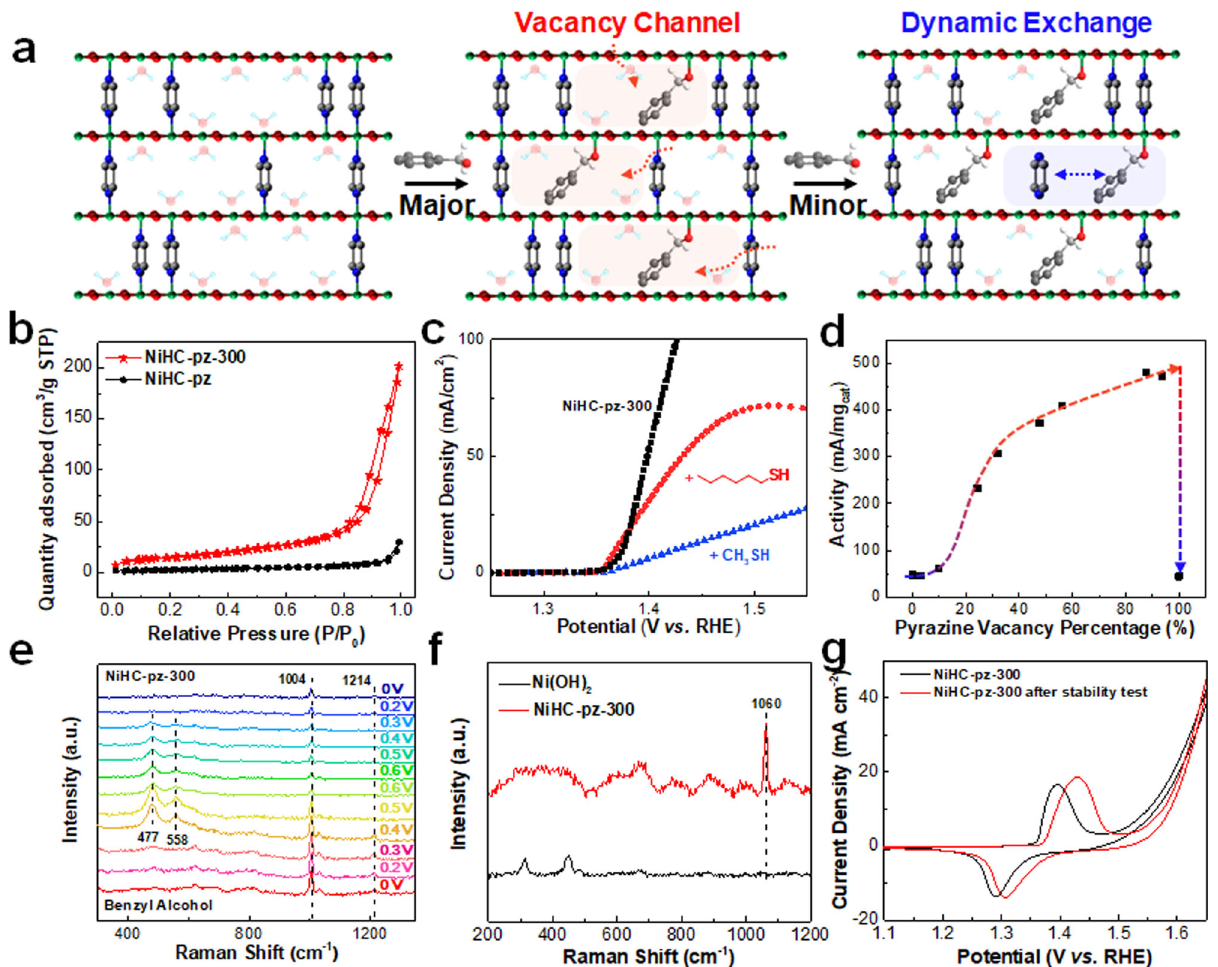
Fig. 4 | Highly accessible Ni sites via vacancy channels and dynamic ligand exchange.a SchematicillustrationofthereactionpathwaysinNiHC-pz-300. b The N 2 sorption isotherms of NiHC-pz and NiHC-pz-300. c The polarization curves of theNiHC-pz-300,methylmercaptanpoisonedNiHC-pz-300and n -hexylmercaptan poisoned NiHC-pz-300 in 1M KOH+0.1M urea. d The structural-activity correla- tion of the gravimetric current density at 1.44V vs . RHE vs. pyrazine vacancy